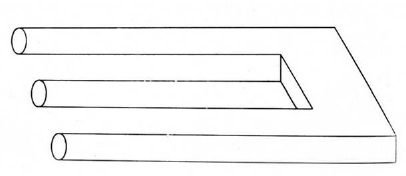
Figure 9. Devil’s pitchfork—a classic impossible